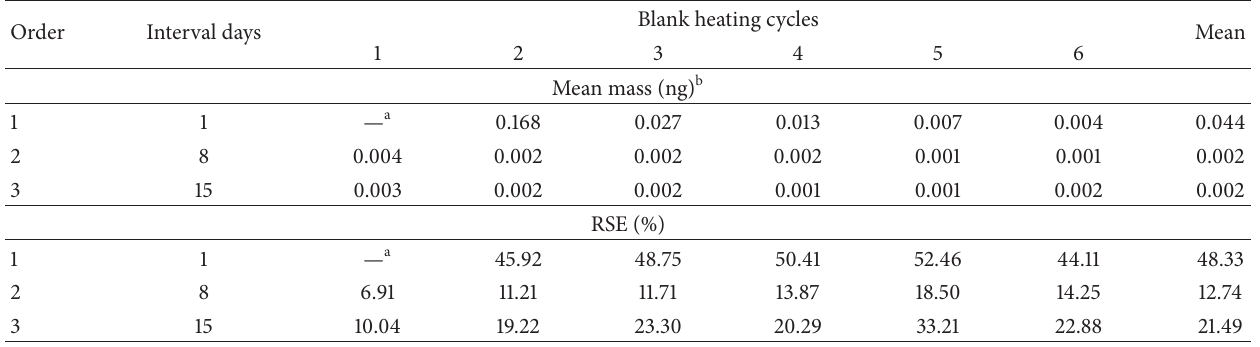
Table 4: Relative standard error (RSE) of blank heating cycles in intermediate-term type A study (Exp. no. 2). Order